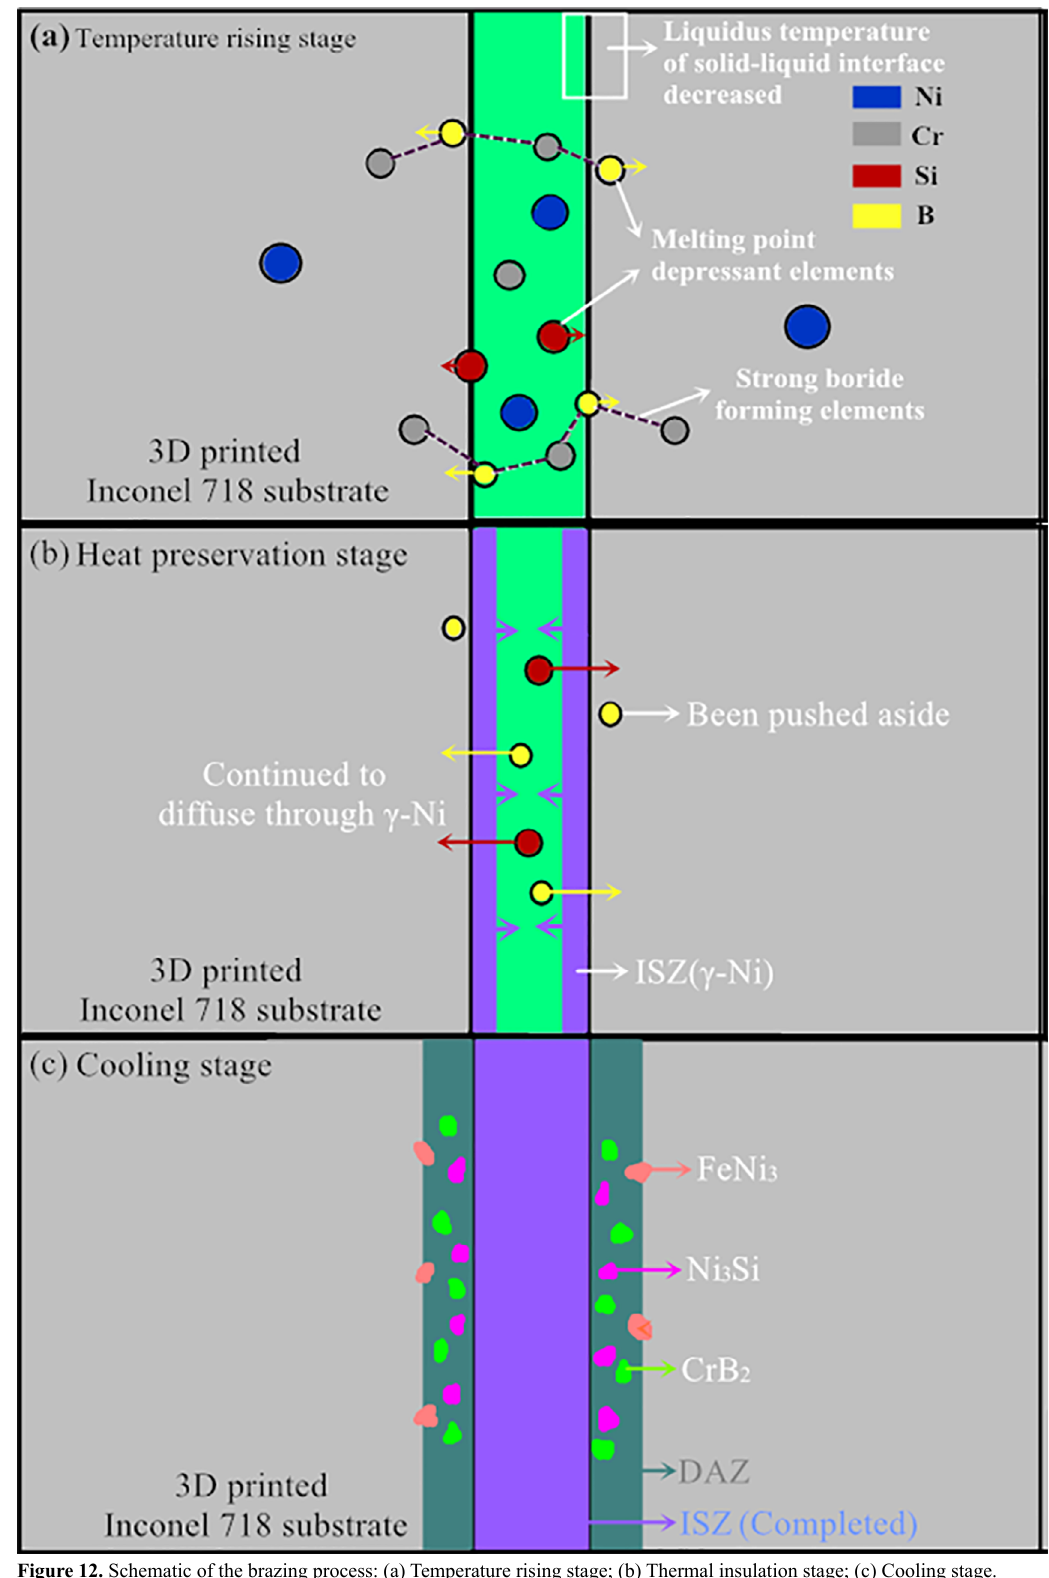
Figure 12. Schematic of the brazing process: (a) Temperature rising stage; (b) Thermal insulation stage; (c) Cooling